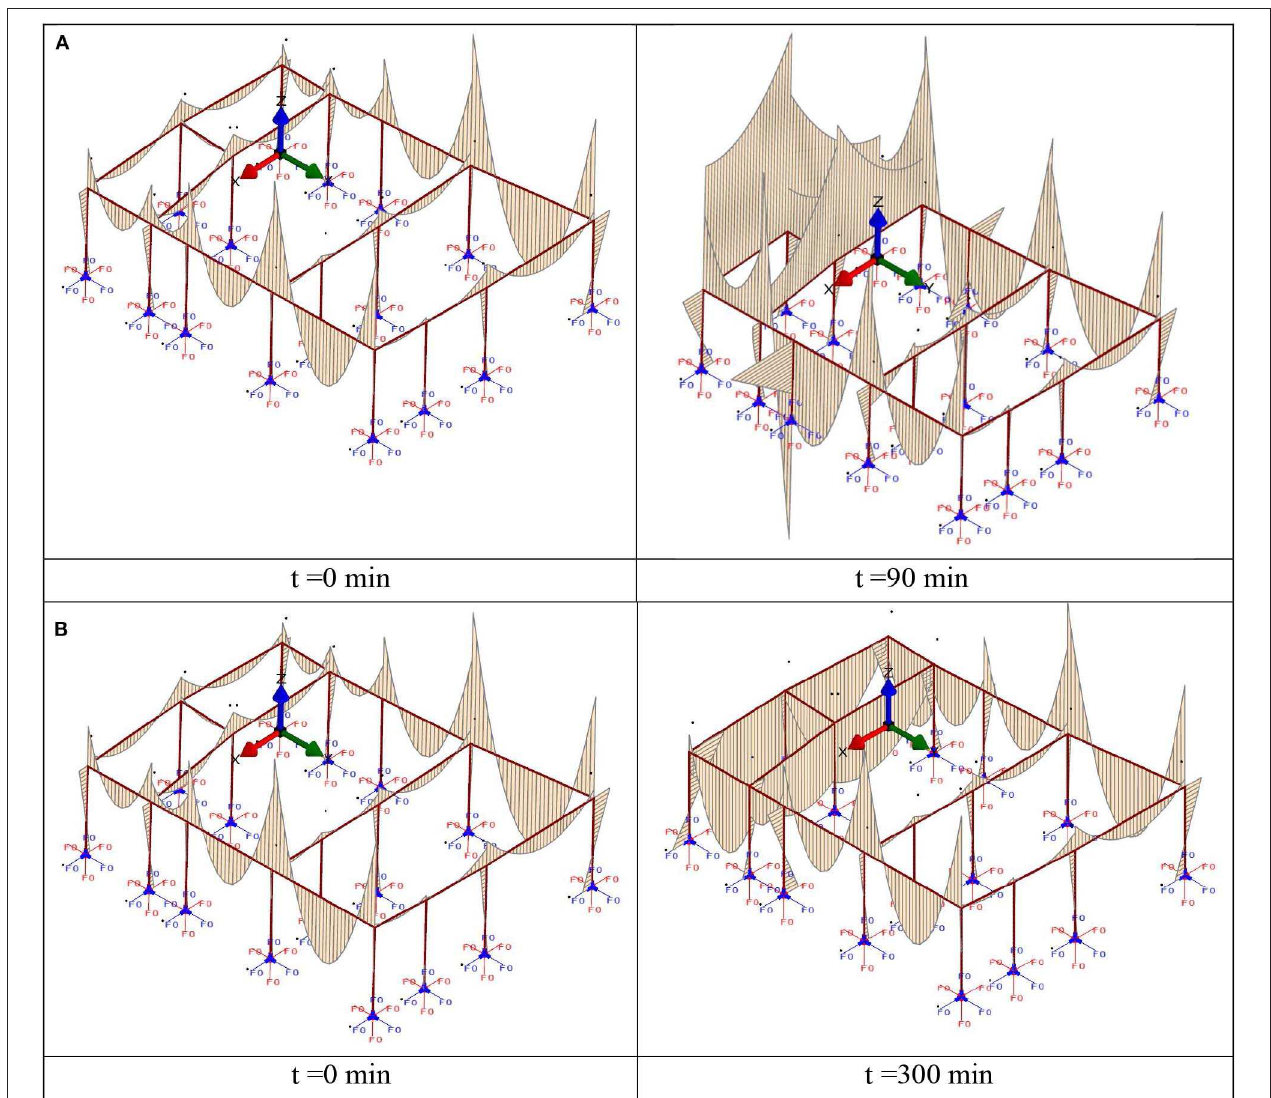
FIGURE 12 | (A) Bending moment on the substructure with ISO834 fire curve. (B) Bending moment on the substructure with library fire curve.